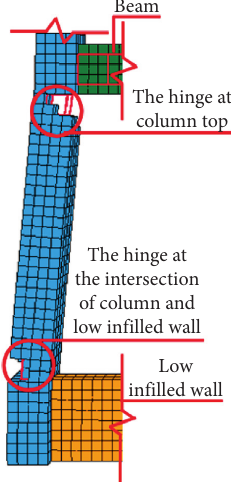
Figure 49: Failure state of first-floor side column.